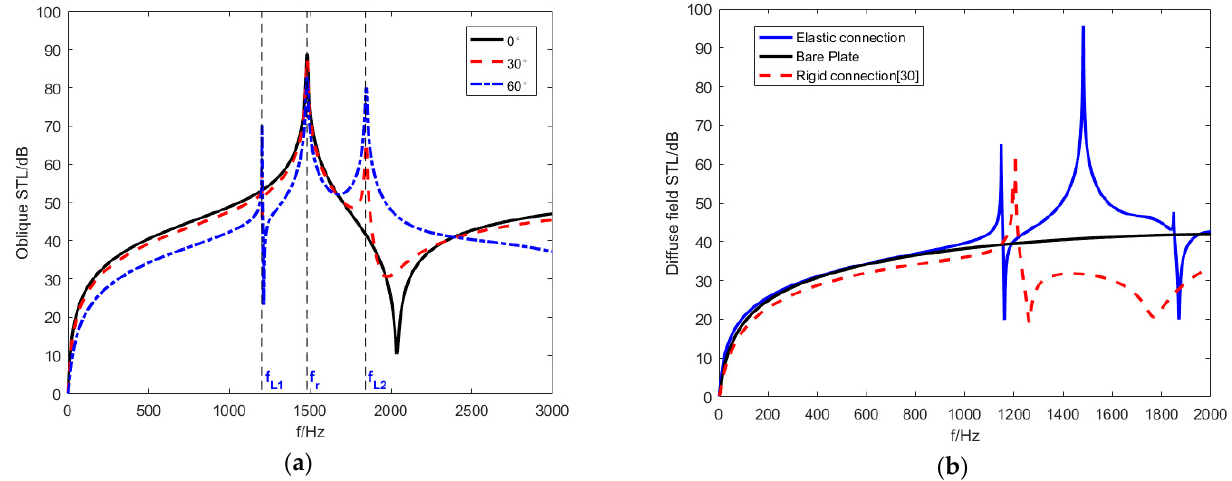
Figure 13. The STL curves at different evelation angles. ( a ) The oblique STL curves ( b ) Diffuse-field STL curves.